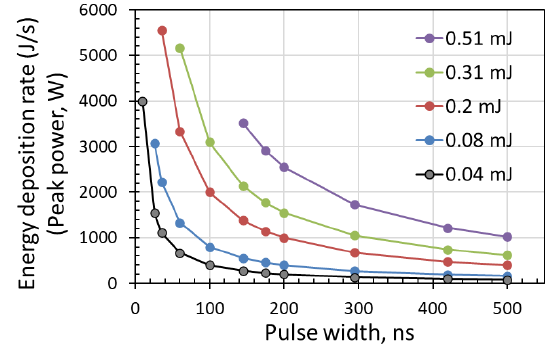
Figure 4. The pulse energy deposition rate in terms of laser peak power versus pulse width at dif- ferent pulse energies